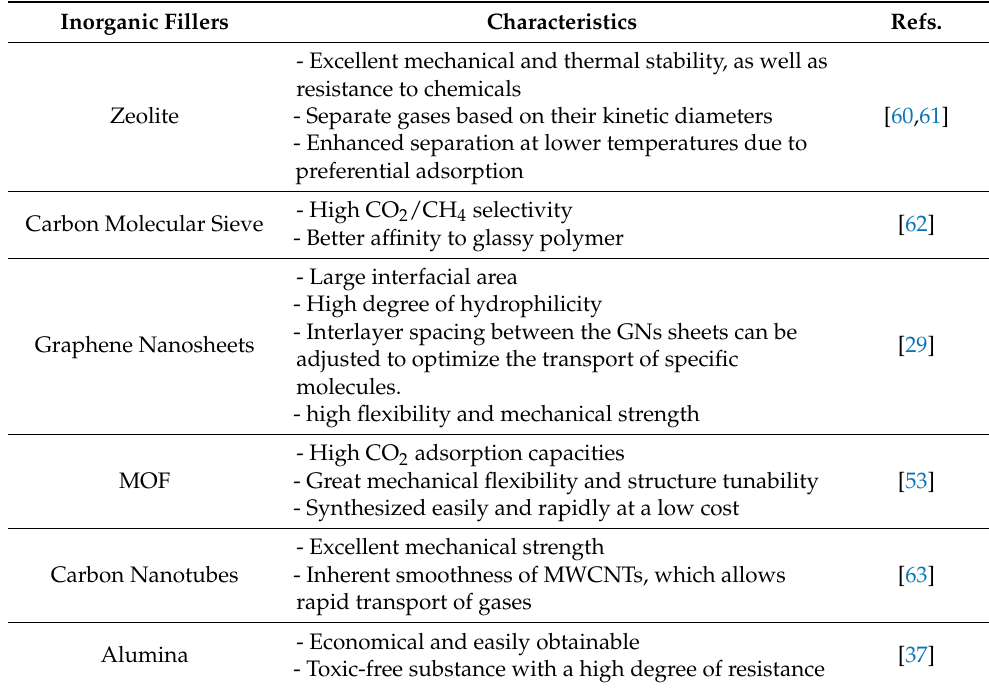
Figure 3. Permeation of gases across inorganic membrane. Reprinted/adapted from Feng et al. [60] © 2022 MPRL. Table 4. Characteristics of inorganic materials .